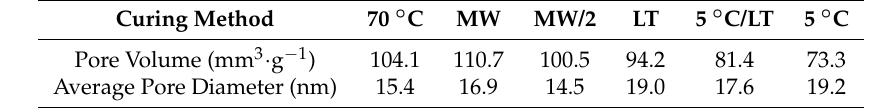
Table 5. Dependence of porosity on cured methods for geopolymers with water glass density 1.5 g·cm −3 .